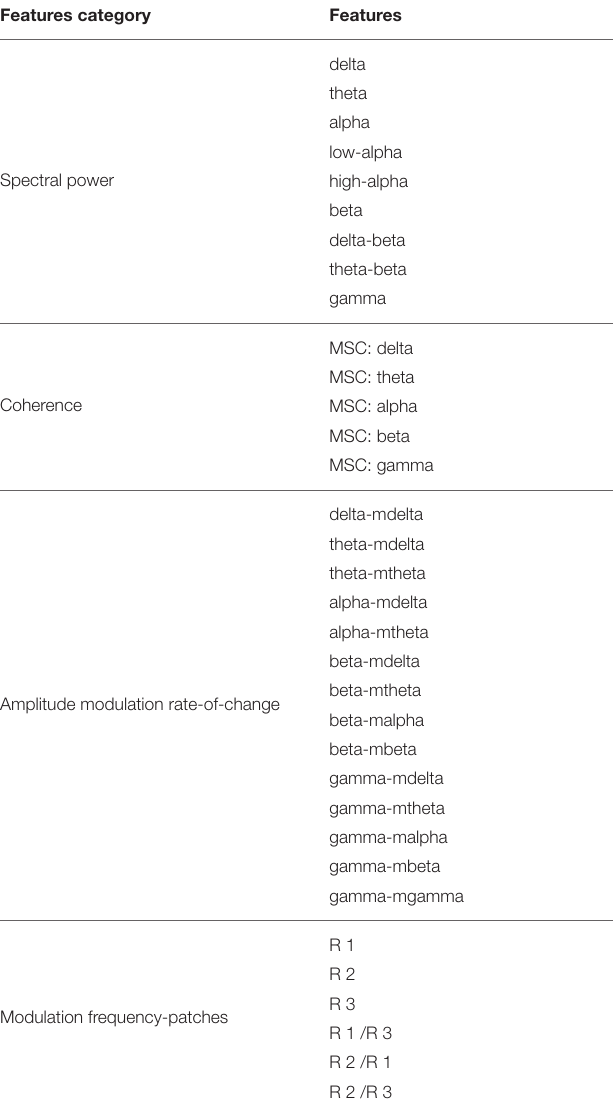
TABLE 1 | Summary of the features computed from EEG signals. Features category